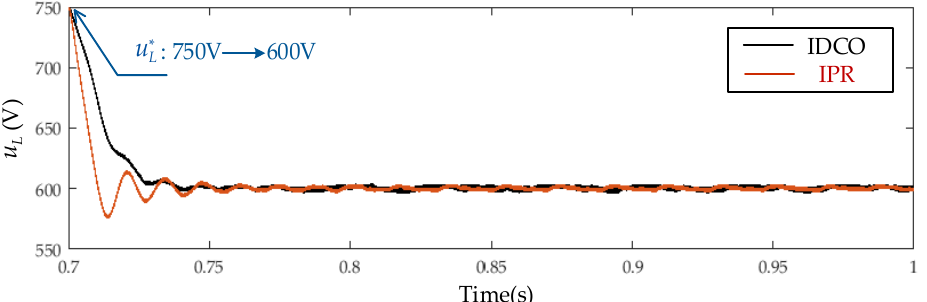
Figure 22. Dynamic waveforms of the LV bus voltage u L based on the IDCO or IPR control method under a reference value step-change.